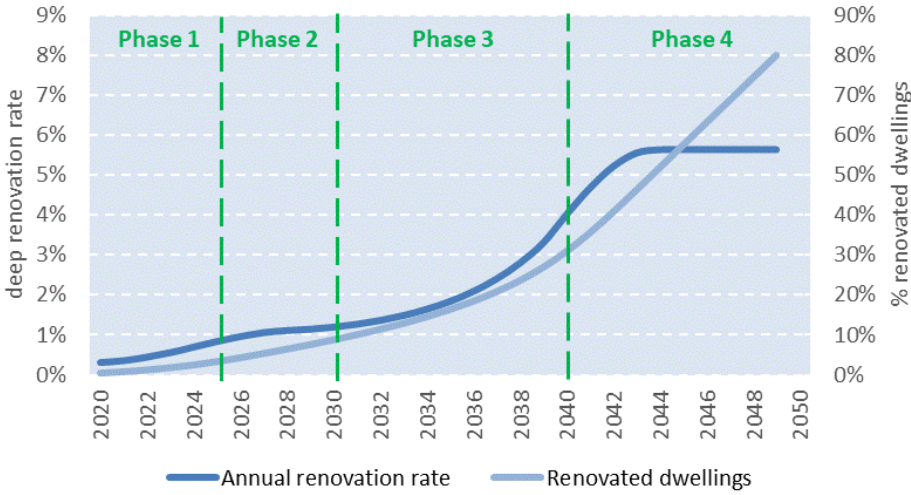
Figure 5. Evolution of the renovation rate to be pursued over the period of